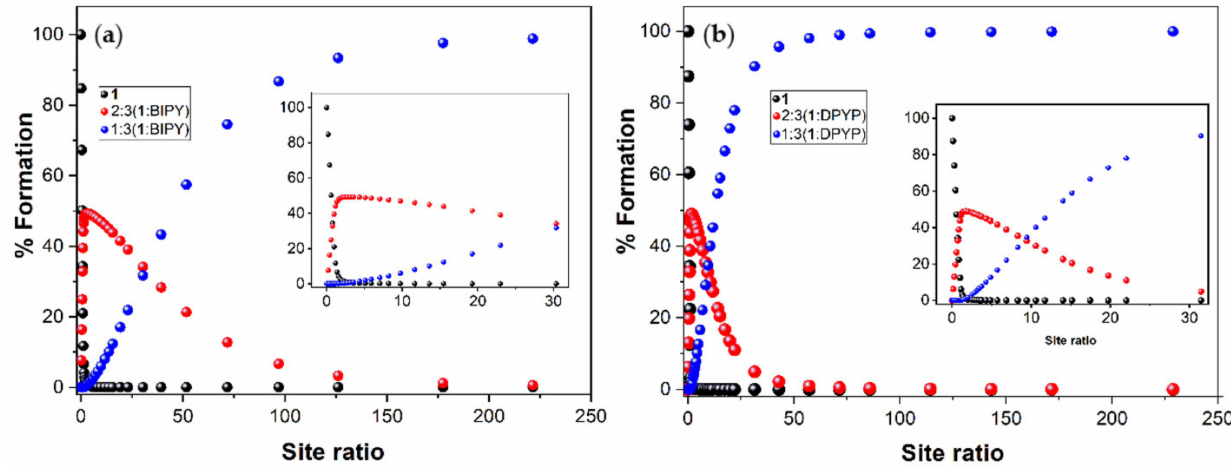
Figure 5. Simulated speciation profiles for titrations of 1 with ( a ) BIPY and ( b ) DPYP. Insets show enlargements of the lower-site-ratio